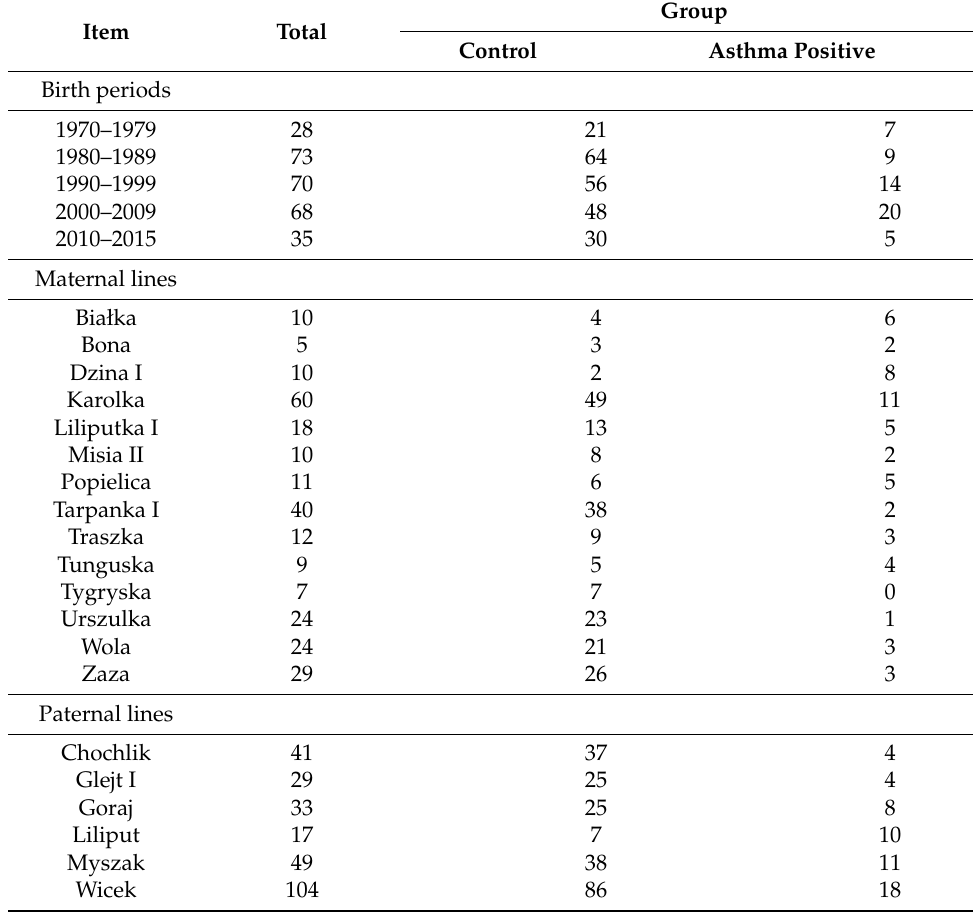
Table 1. Number of individuals per subclass across investigated